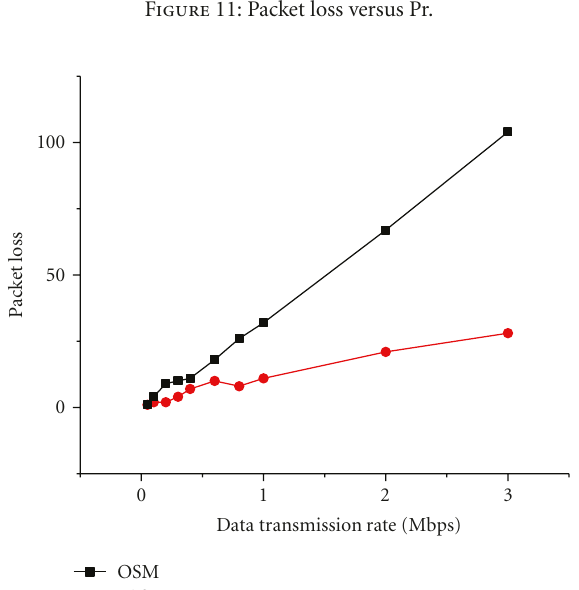
Figure 13: Packet loss versus moving speed of the MN.